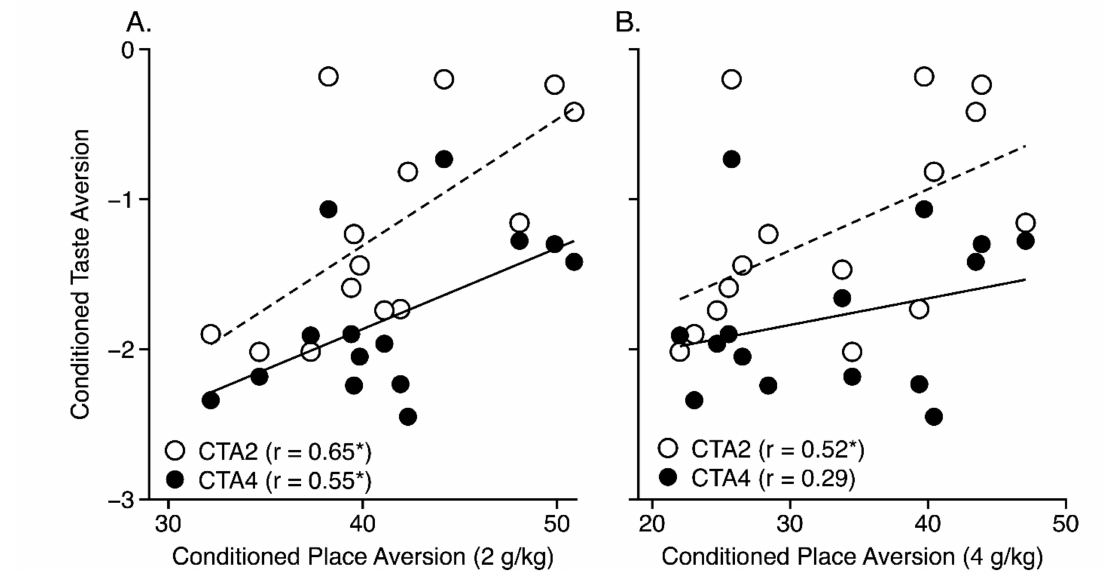
Figure 7. Scatterplots showing the genetic correlations between ethanol-induced conditioned taste aversion indexed as the change in fluid intake between the first and second taste conditioning trial [13] (y axis) and conditioned place aversion indexed as mean percent time on the ethanol-paired floor (x-axis) for the ( A ) 2- and ( B ) 4-g / kg conditioned place aversion groups. The open symbols and dashed lines represent mice given taste conditioning with 2 g / kg, whereas the closed symbols and solid lines represent mice given taste conditioning with 4 g / kg. Each point represents the strain mean scores for both